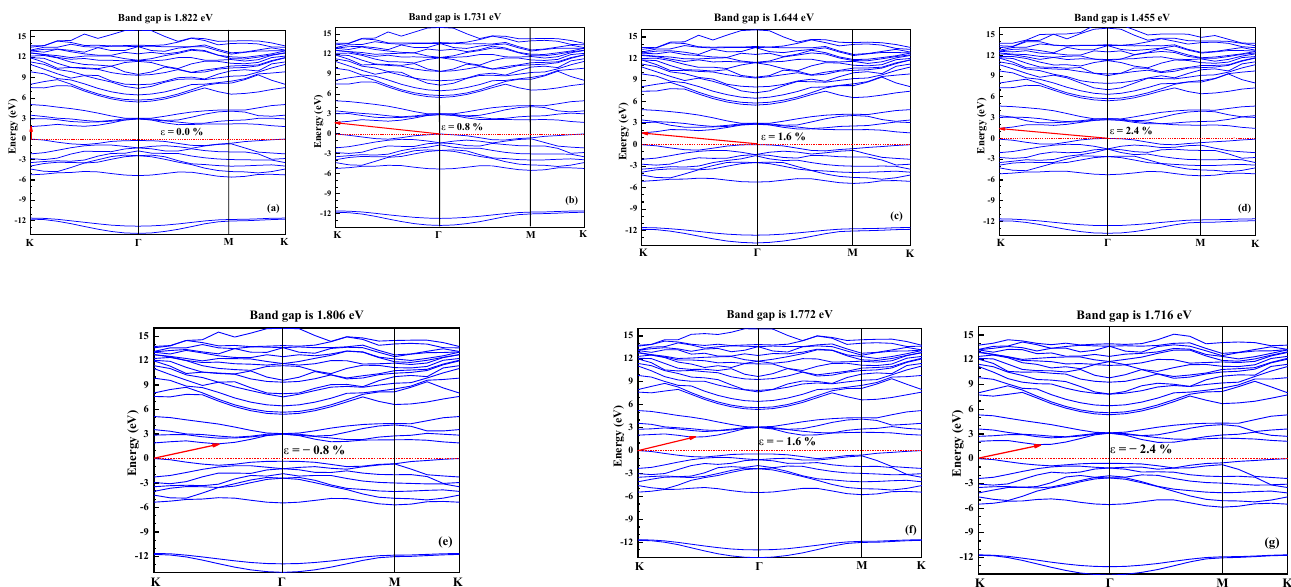
Figure 2. Band structure of single-layer MoS 2 under different strains. As shown in Figure 3, as the strain increases (whether it is tensile strain or compressive strain), the band gap of the single-layer MoS 2 becomes smaller. Under tensile strain, the band gap decreases much more than under compressive strain. This is because